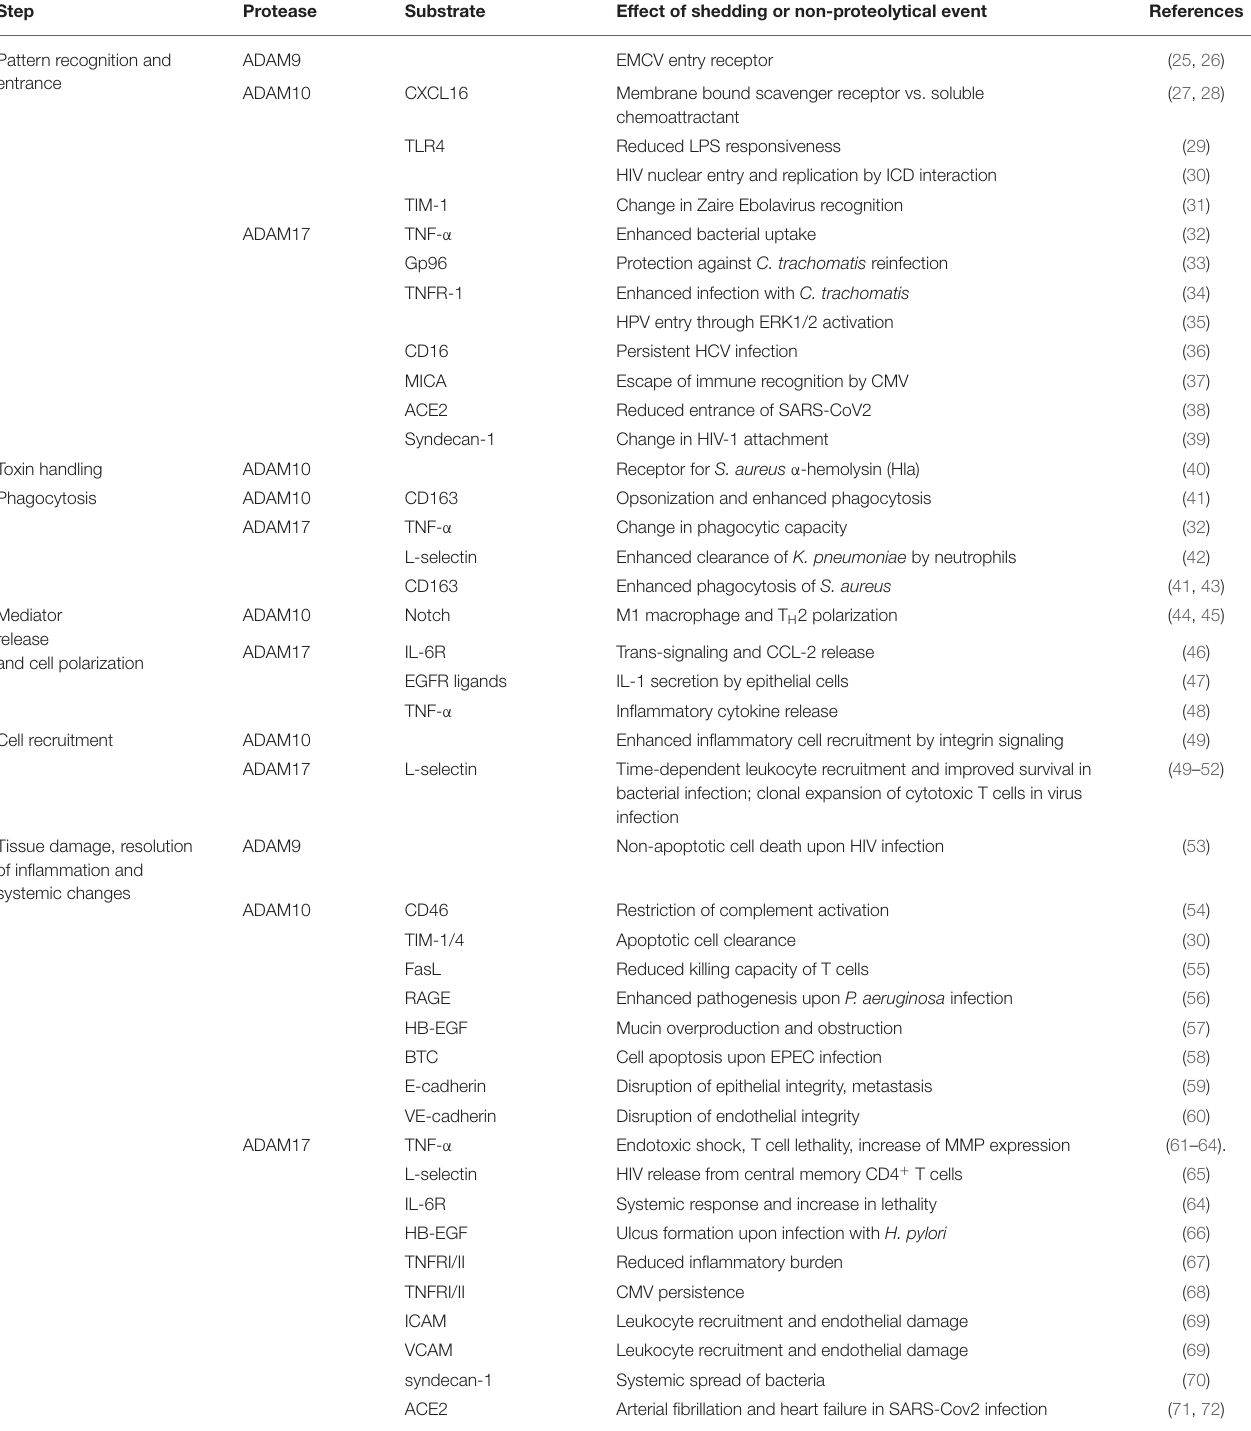
TABLE 1 | Function of ADAM proteases in